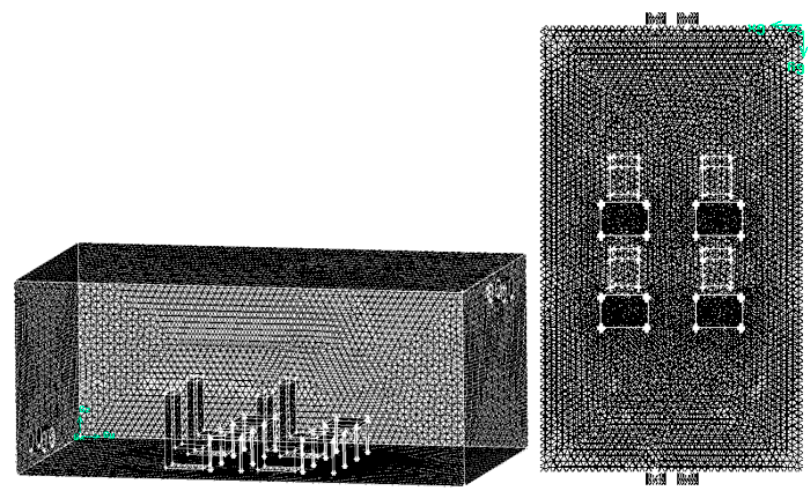
Figure 4. Computational grid of the artificial climate chamber model.